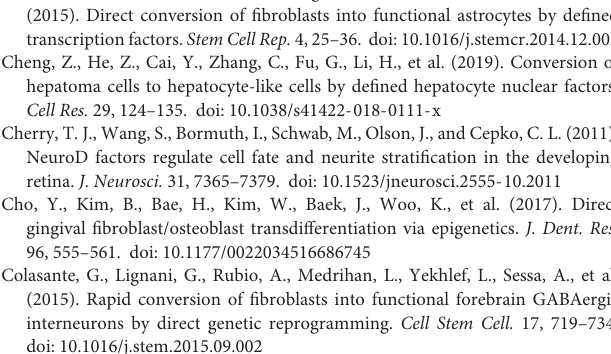
FIGURE S1 | The number of genes only in the respective stem cell in contrast to up-regulated genes. FIGURE S2 | Heatmap of the expression relative value of the 37 core genes in the respective stem cells and MEF. FIGURE S3 | The continued protein-protein interaction network contains 823 nodes and 3113 edges. The nodes were painted as colors such as turquoise, blue, brown, yellow, purple, and pink corresponding to the stem cell-respective modules. FIGURE S4 | Random occupancy rates of the CTCF binding motif. Random sampling was used to evaluate the genome-wide CTCF binding sites. FIGURE S5 | The percentages of common up-regulated genes both in mouse and human stem cells are different among the 5 types of human stem cells. Mouse_homolog means the up-regulated genes of mouse respective stem cells corresponding to human homologous genes. The percentage was calculated by compared gene amount of respective sections to the sum of mouse and human up-regulated genes. TABLE S1 | Primer sequences used in this study. TABLE S2 | The highly expressed gene lists of each types of stem cell. TABLE S3 | The gene lists of stem cells respective special modules. Those identified mouse stem cell special genes which also up-regulated in human stem cells were highlighted with yellow color. TABLE S4 | Whether or not of those core genes were up-regulated in the respective human stem cells. TABLE S5 | The relative expression foldchanges of those annotated homologous genes between mouse and